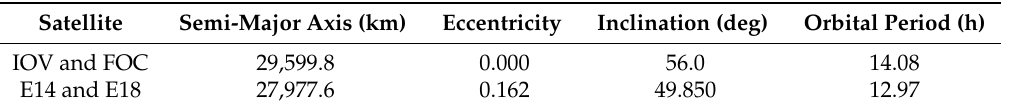
Table 1. Galileo satellite orbital parameters. IOV, In-Orbit Validation; FOC, Full Operational Capability.